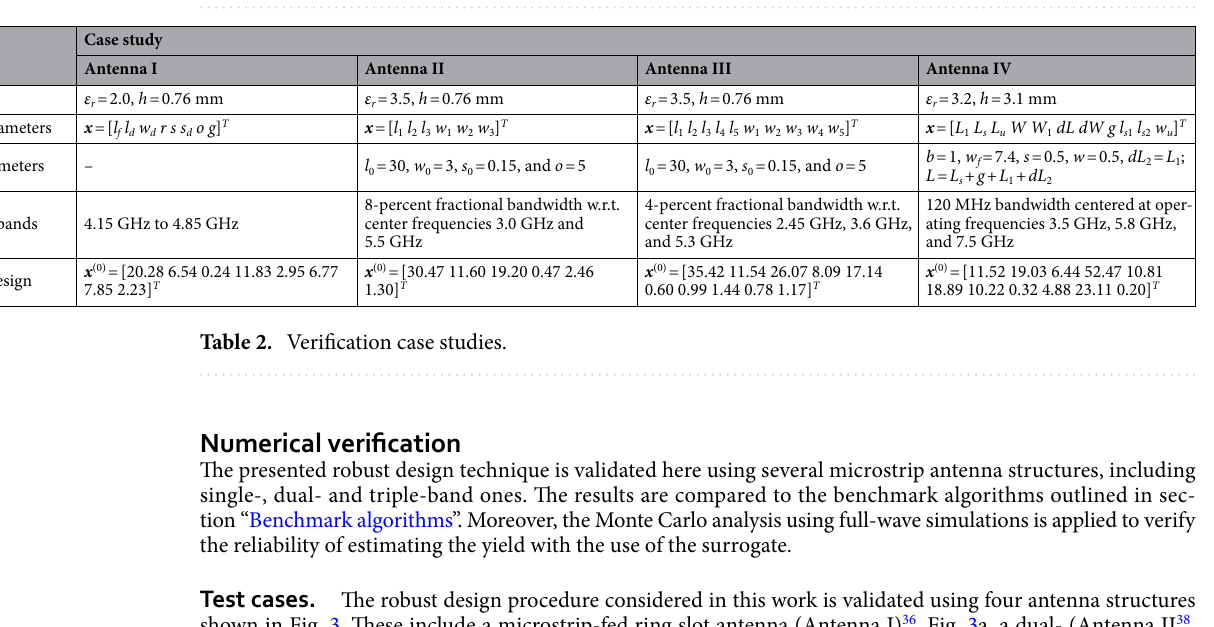
Figure 3. Verification case studies: ( a ) microstrip-fed ring slot antenna (Antenna I) 36 , ( b ) dual-band uniplanar dipole antenna (Antenna II) 38 , ( c ) triple-band uniplanar dipole antenna (Antenna III) 38 , ( c ) triple-band U-slotted patch antenna (Antenna IV) 39 .